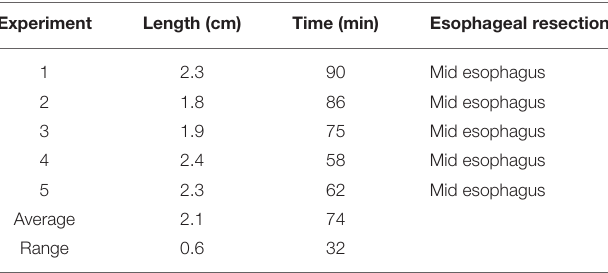
TABLE 1 | Five experimental subjects undergone endoluminal transgastric esophagectomies.